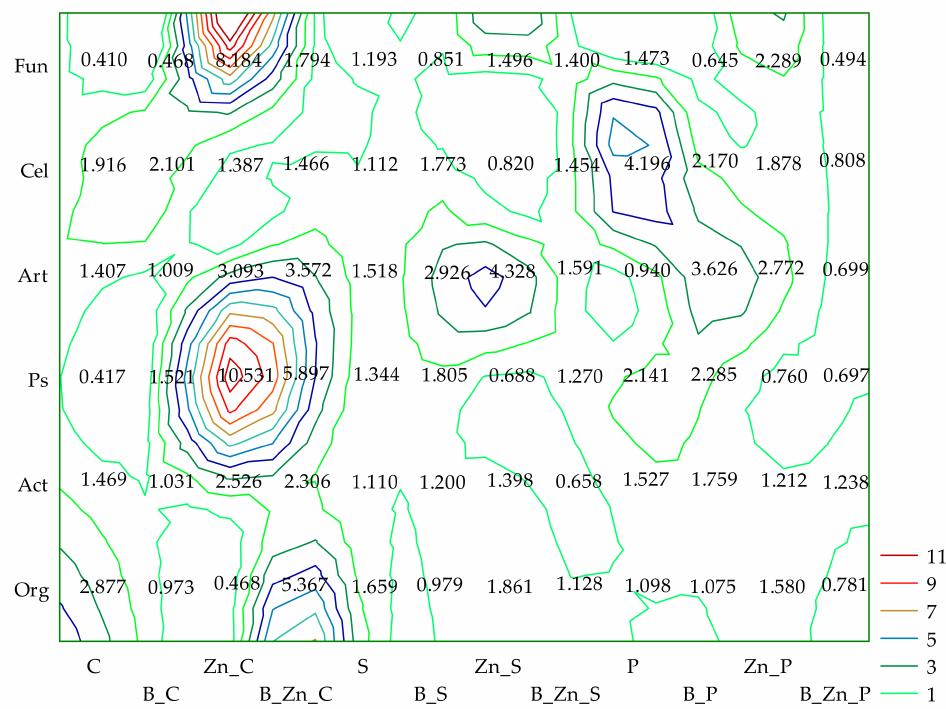
Figure 6. The coefficient of the influence of humic acid (IF H ) on the number of organotrophic bacteria (Org), actinomycetes (Act), fungi (Fun), Pseudomonas sp. (Ps), Arthrobacter sp. (Art), and cellulolytic bacteria (Cel) in soil uncontaminated and contaminated with B, Zn 2+ , and B + Zn 2+ ; S— Sorghum Moench , P— Panicum virgatum ; C—uncontaminated soil; B—bisphenol A; Zn—ion zinc (Zn 2+